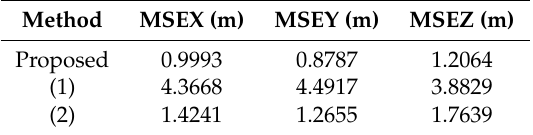
Table 7. Total Mean Squared Error of the estimated initial position of